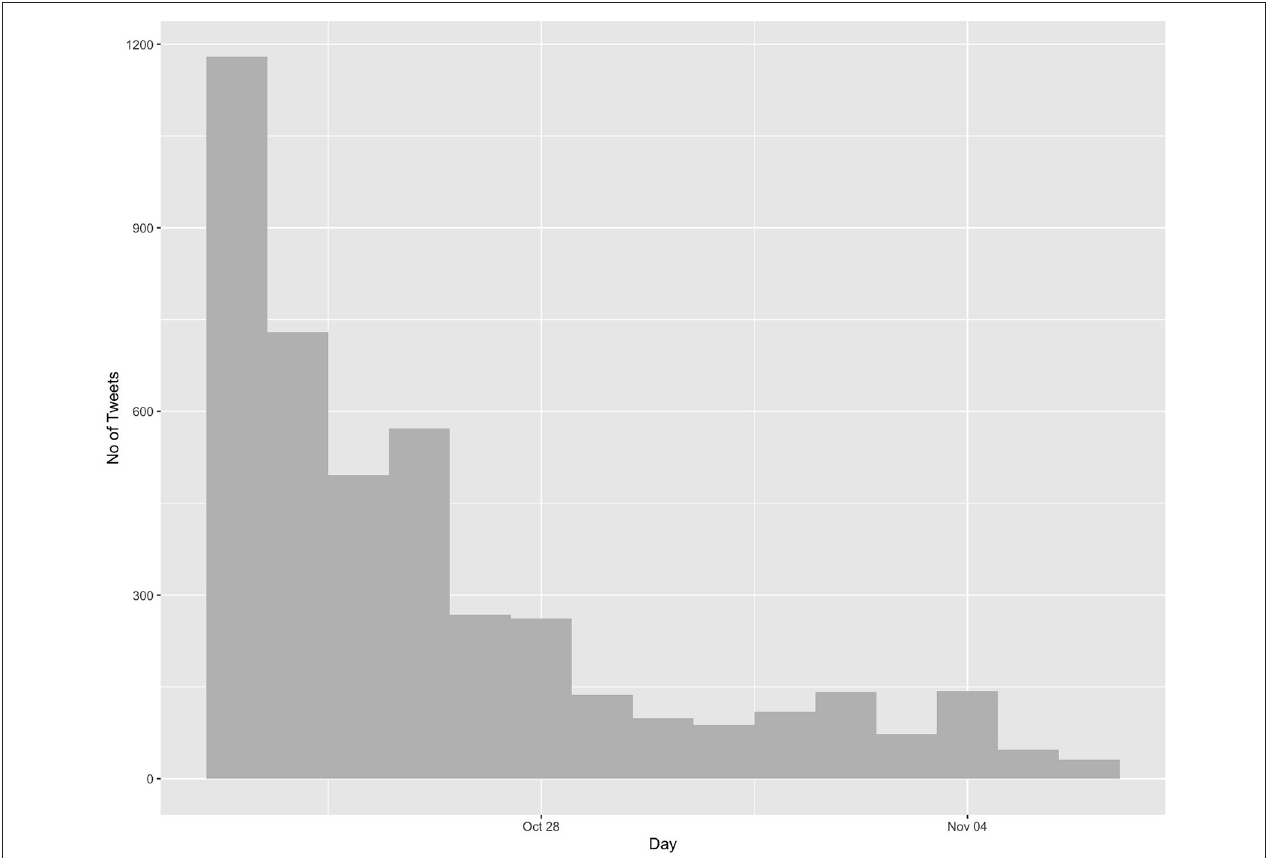
FIGURE 3 | Distribution of tweets per day in the 2 weeks immediately after the Lorry Deaths incident ( N =